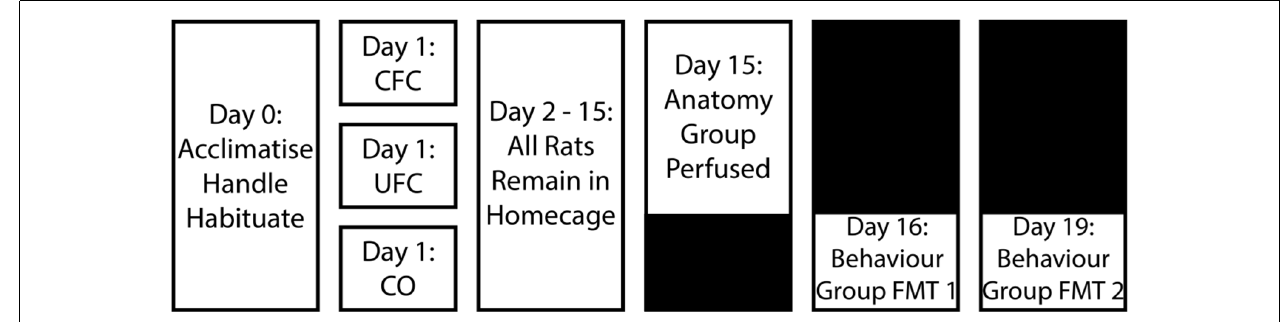
FIGURE 1 | Experimental design for behavioural training. Following a period of acclimatisation to the vivarium, handling and habituation to the fear conditioning context, rats were divided into three behavioural groups. Rats in the occupying context A were provided with five non-overlapping and random electric shocks to the foot (CFC group). Alternatively, another group of rats in context A were provided with the same foot-shocks, as well as five non-overlapping and random auditory tones (UFC group). The final group of rats (CO control group) were placed into context A and left undisturbed without the addition of any stimuli. After conditioning, all rats were returned to their home cages and left undisturbed for 2 weeks. Rats were further sub-divided into a behavioural (provided with two fear memory tests (FMT) separated by 3 days) and anatomical (perfused 2 weeks post-conditioning) group. CFC, Contextual fear conditioning; UFC, unpaired fear conditioning; CO, context